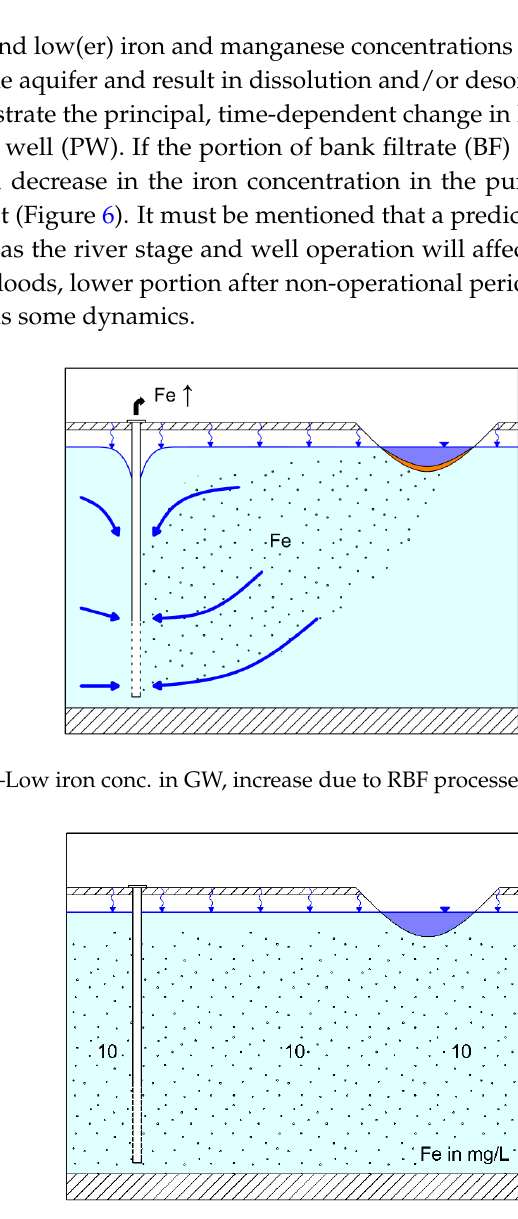
Figure 3. Case B – High iron-conc. in GW feeding the river, low iron conc. near groundwater surface. Water 2017 , 9 , 317